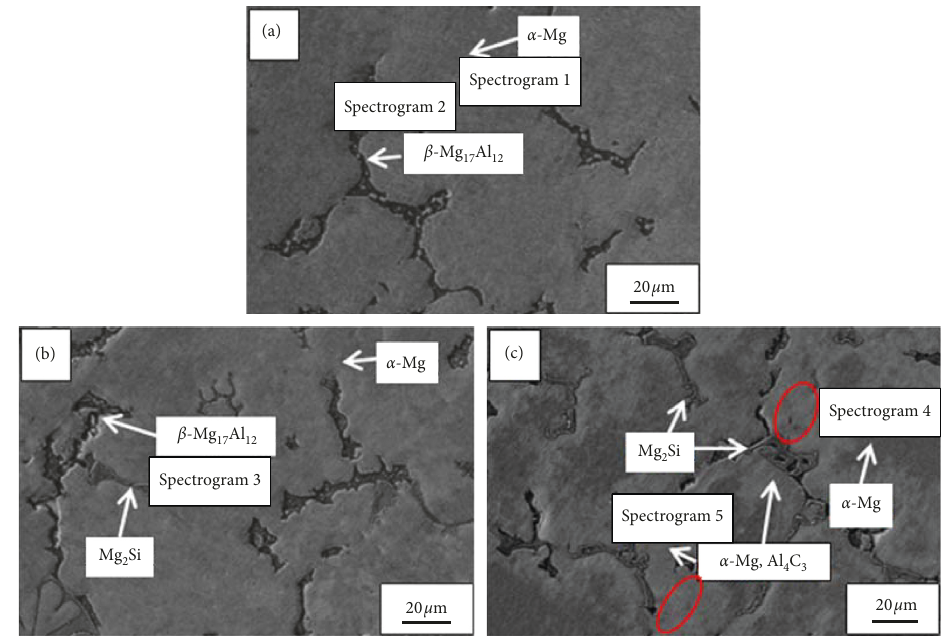
Figure 3: High times SEM of AZ91D magnesium alloy and Cu-SiC AZ91D, and (c) pulsed electric field+Cu-SiC p /AZ91D).